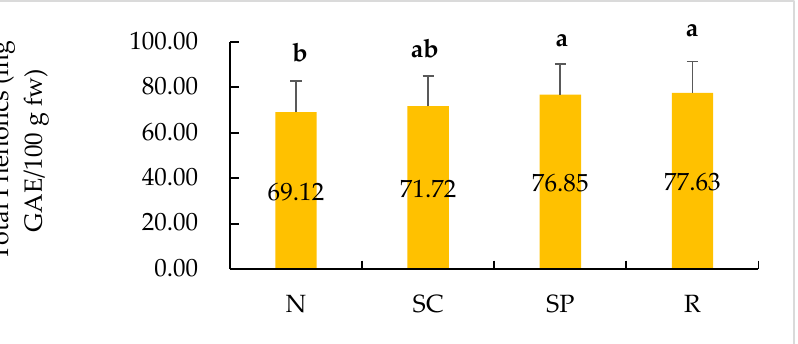
Figure 5. Comparisons of total phenolics (mg GAE/100 g fw) among four skin types including, normal (N), surface cracking (SC), silver patch (SP), and russeting (R) in two-year samples. Means that do not share a common letter are significantly different.